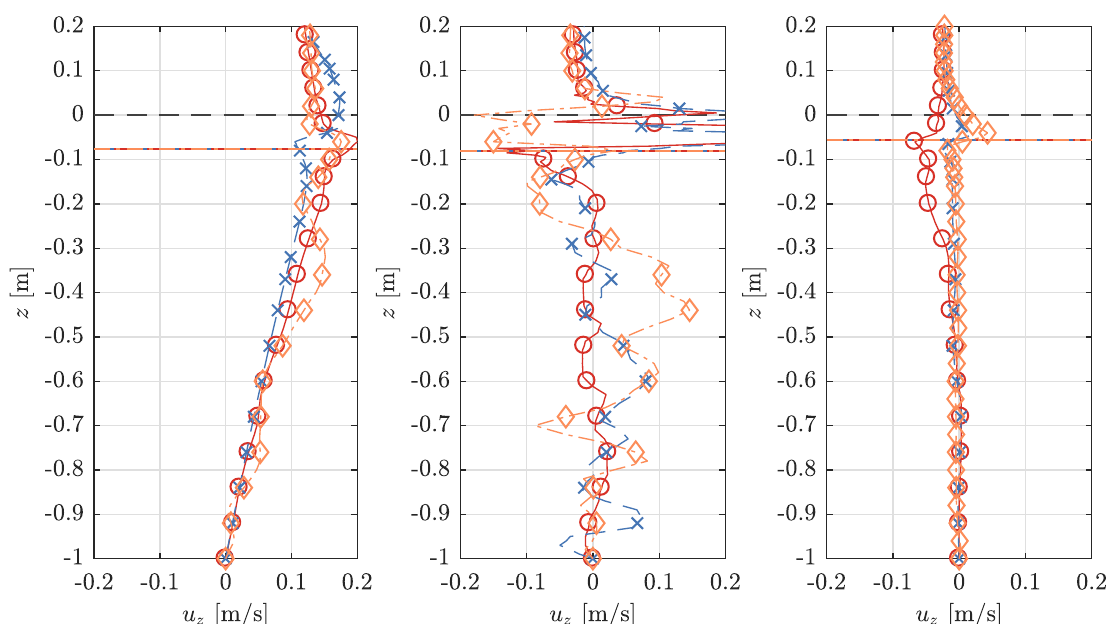
Figure 12. Velocity profiles in horizontal, u x , and vertical, u z , direction at the cylinder centre (WG B2), 0.5 m before (WG B1) and 0.5 m after (WG B3) the axis for a wave trough at the cylinder centre.